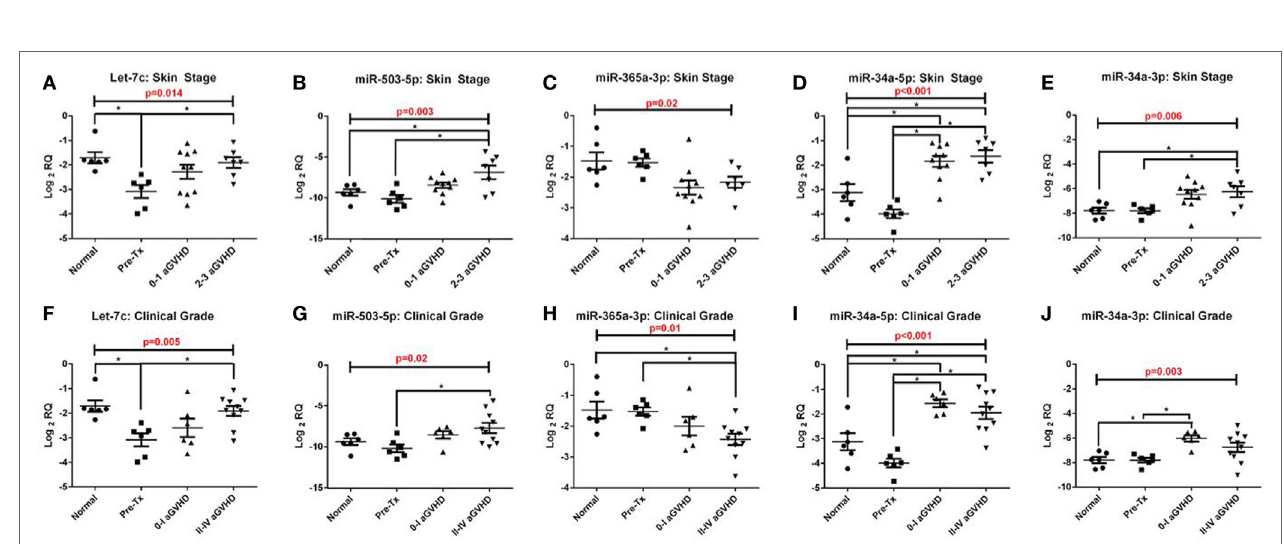
FigUre 2 | Let-7c-5p, miR-503-5p, miR-365a-3p, miR-34a-5p and miR-34a-3p expression in the validation cohort skin biopsies. MicroRNA expression results for (a,F) let-7c-5p, (b,g) miR-503-5p, (c,h) miR-365a-3p, (D,i) miR-34a-5p and (e,J) miR-34a-3p were analysed on the basis of (a–e) histopathological skin aGvHD stage (0–3, n = 17) and (F–J) the overall aGvHD clinical grade (0–IV, n = 16). Kruskal-Wallis analysis of variance was used to determine the significance, set at p ≤ 0.05 (*). Scatterplots show the mean and SEM. Abbreviations: Normal, healthy controls; Pre-Tx, Pre-transplant.